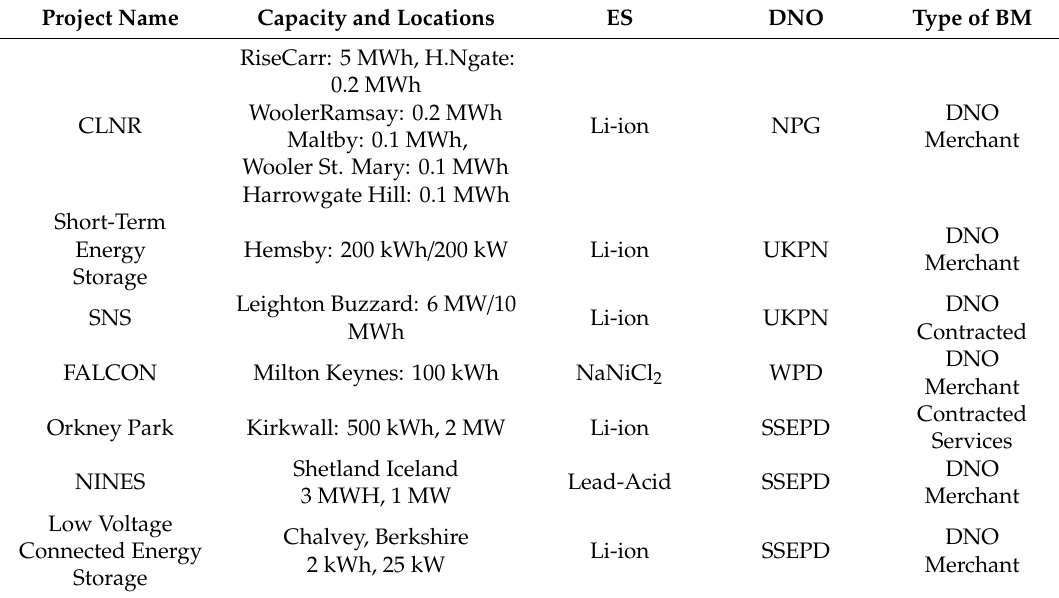
Table 3. Some of BESS projects in the UK including their capacity, locations, type, DNO name, and the type of the business